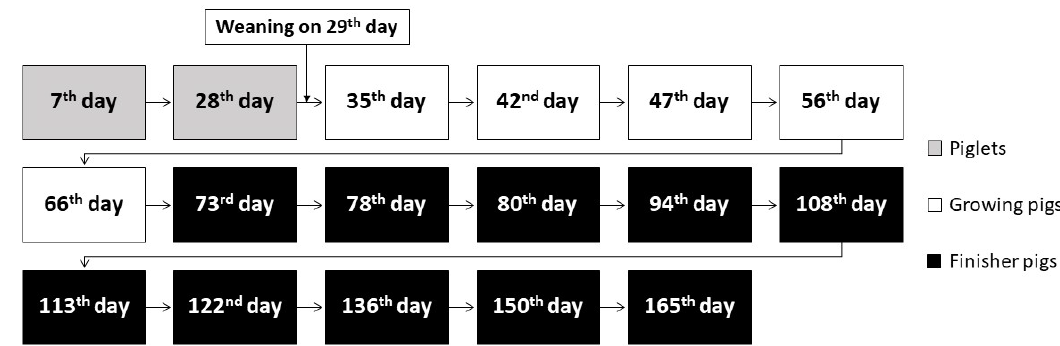
Figure 1. Feces sample collection across piglets’ maturation, during the conducted research. To avoid data overload, only the results obtained from samples collected at the beginning and the end of each growth phase were presented in the following paper.